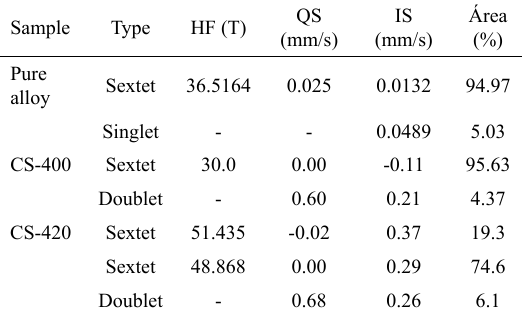
Figure 9. Mössbauer spectroscopy results of the sample: a) Pure alloy. b) CS-400. c) CS-420. Table 5. Hyperfine parameters obtained from Mössbauer